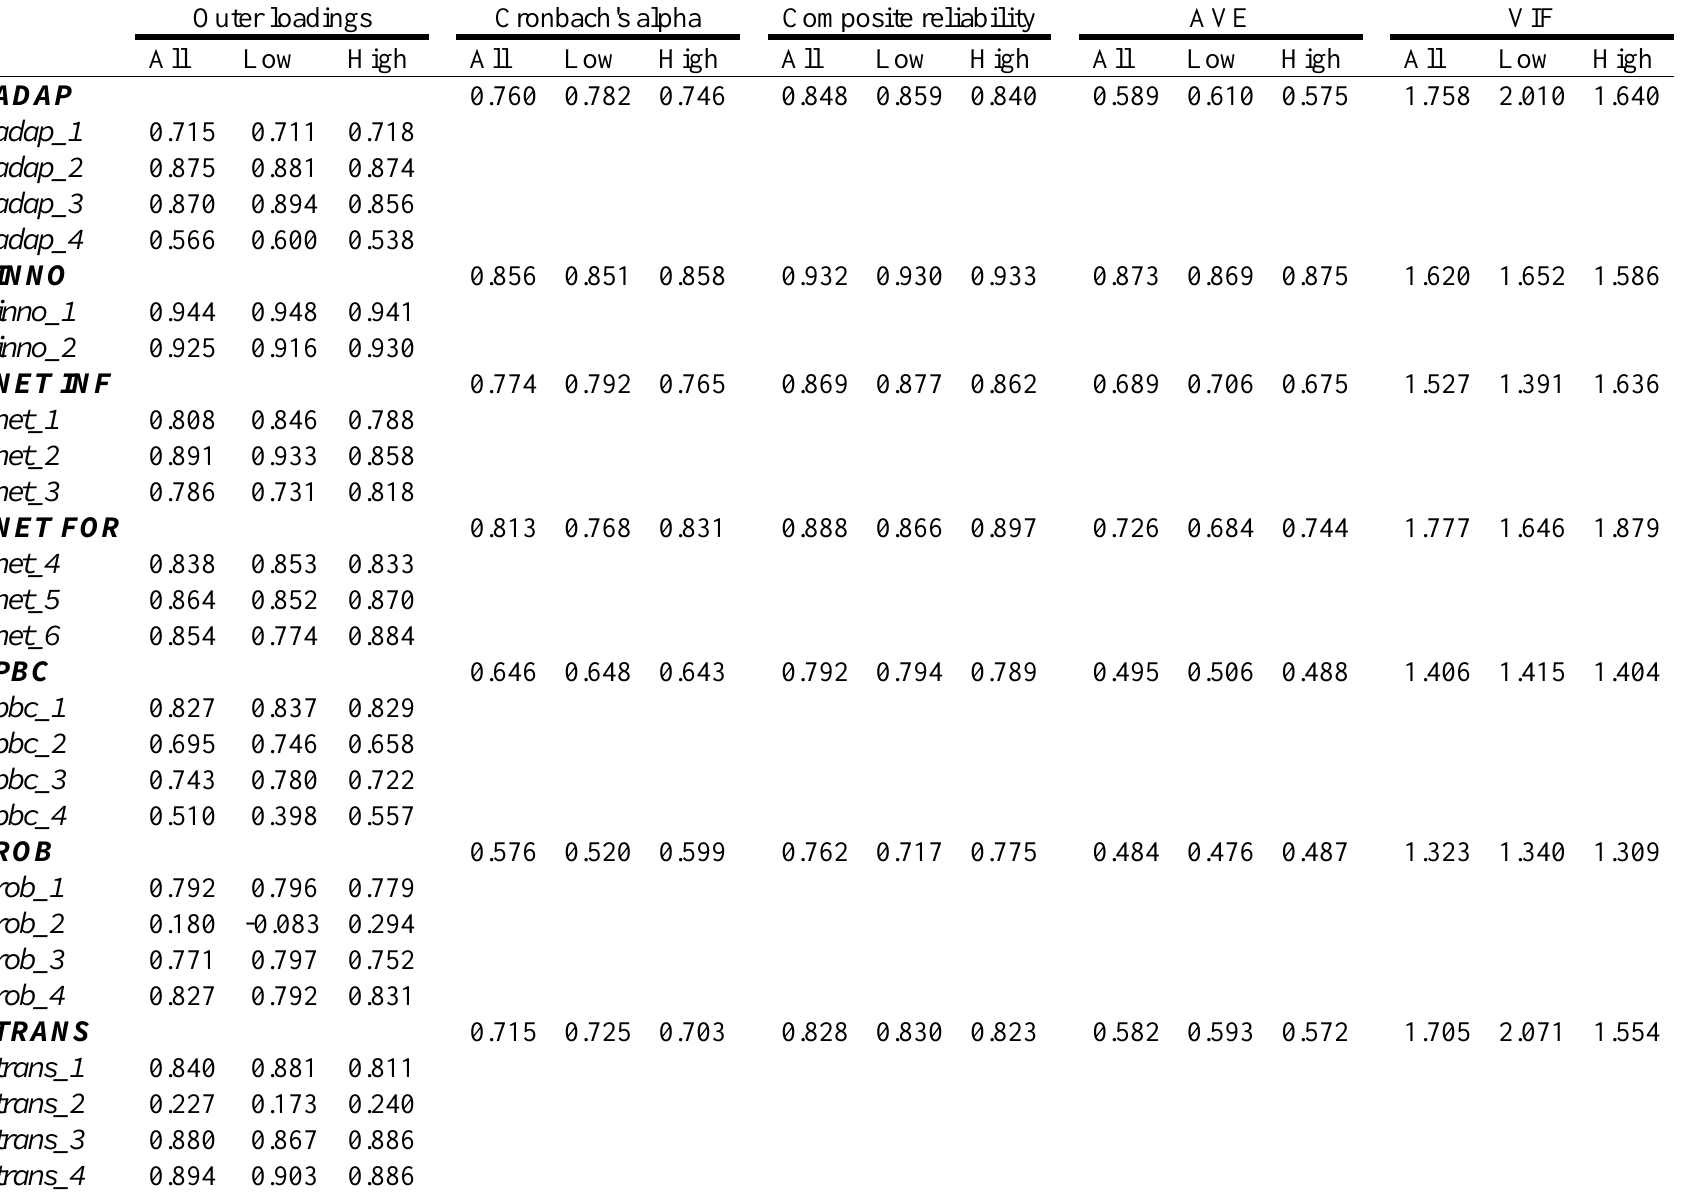
Table A1.2 Item reliability, internal validity reliability, convergent validity and VIFs of the reflective indicators (full model ) Outer